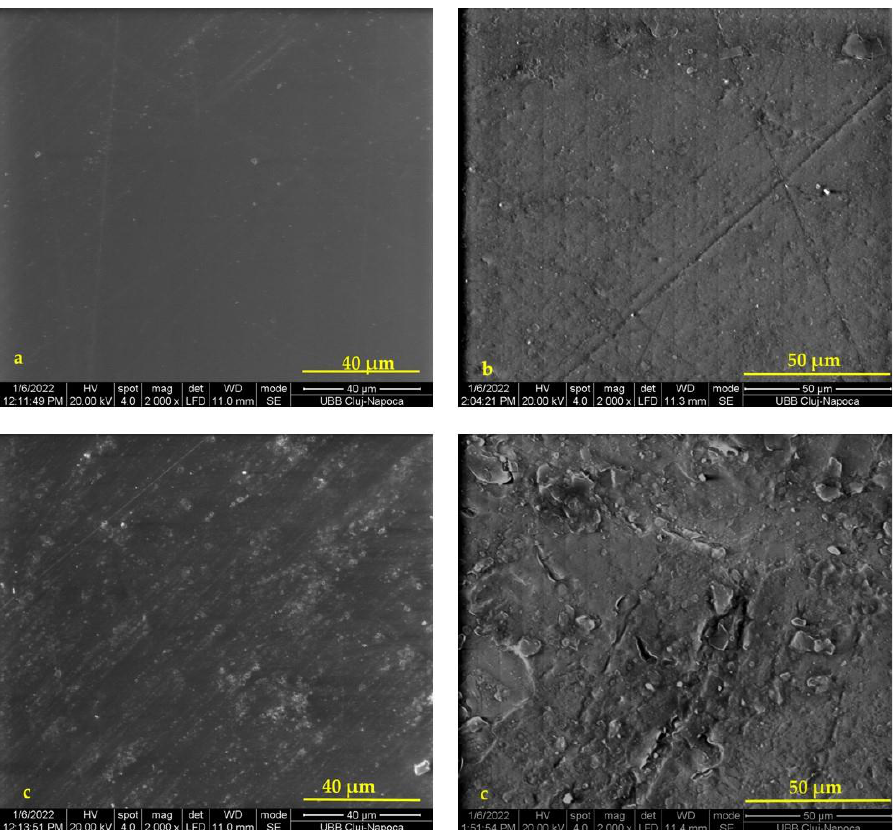
Figure 3. SEM images (×2000) of the surfaces of the P2F and Icon samples ( a , b ) before and ( c , d ) after immersion in water.